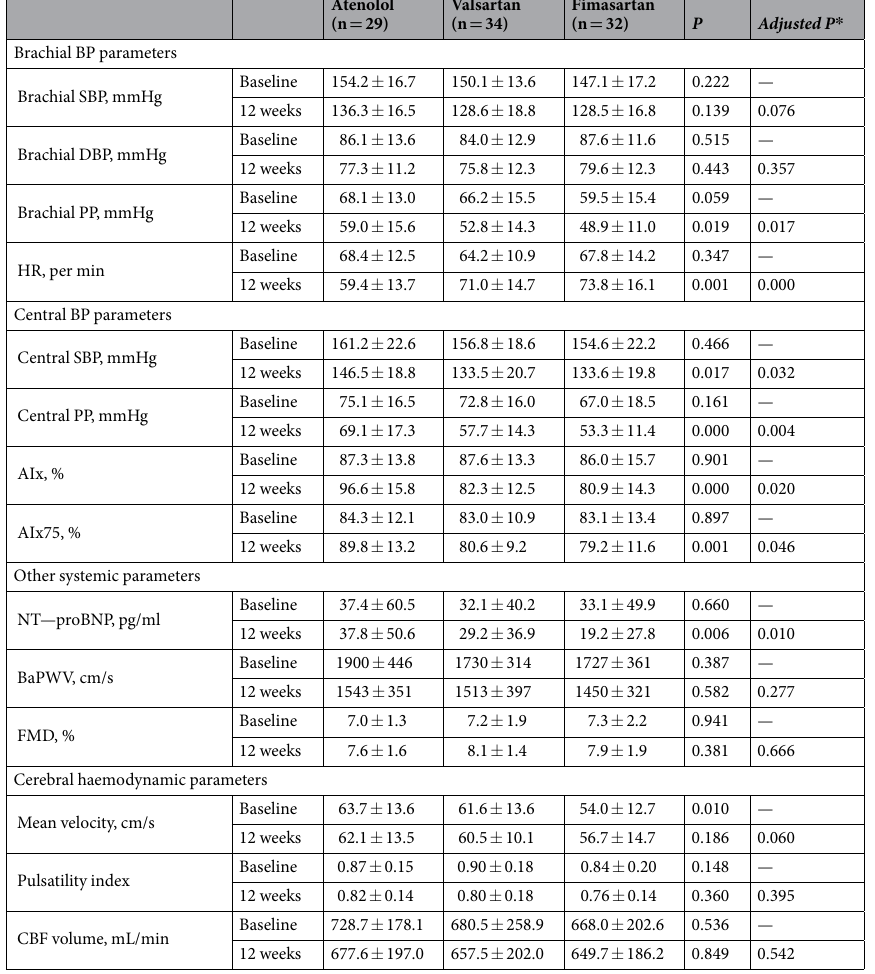
Table 2. Central and cerebral haemodynamic parameters at baseline and after 12 weeks between the three groups. All values are presented as mean ± standard deviation. * Adjusting baseline values by repeated measures analysis of variance, AIx indicates augmentation index; AIx75, augmentation index adjusted for heart rate; BaPWV, brachial-ankle pulse wave velocity; BP, blood pressure; CBF, cerebral blood flow; DBP, diastolic blood pressure; FMD, flow-mediated dilation; HR, heart rate; NT-proBNP, N-terminal pro-brain natriuretic peptide; SBP, systolic blood pressure; PP, pulse